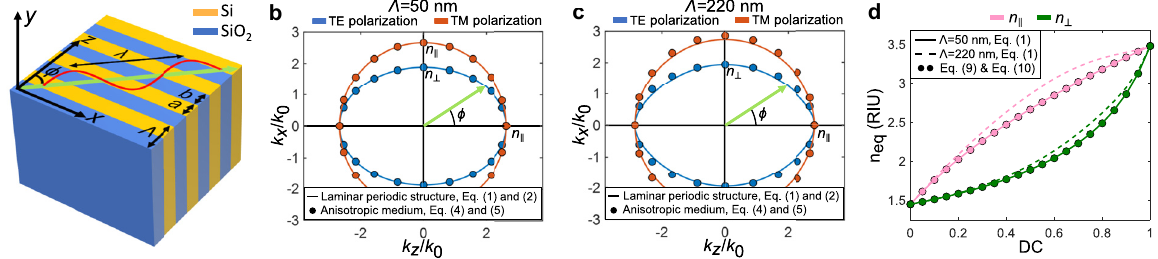
Figure 3: (a) Laminar periodic structure comprising two transversely infinite materials arranged along the z -axis with a period Λ . The laminae havelengths a =DC ⋅ Λ and b =(1 − DC)· Λ ,andrefractiveindices n 1 and n 2 .(b),(c)Comparisonbetweenthenormalizedwavevectorcomponents, k x and k z , of a plane wave propagating along any angle of the laminar periodic structure (DC = 0.5) and of its equivalent anisotropic homogeneous material for the structure operating in the (b) long-wave regime, Λ = 50 nm, and (c) subwavelength regime, Λ = 220 nm. (d) Dependence with the duty cycle of the permittivity tensor components n ∥ and n ⊥ of the equivalent anisotropic homogeneous